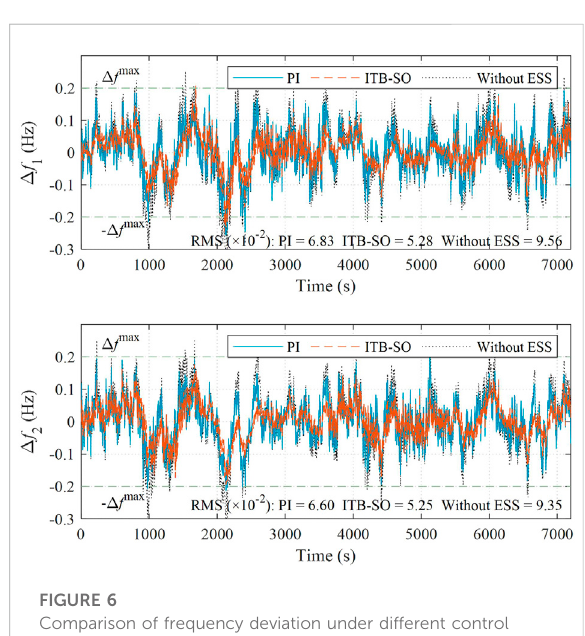
FIGURE 6 Comparison of frequency deviation under different control methods of (A) area 1 and (B) area